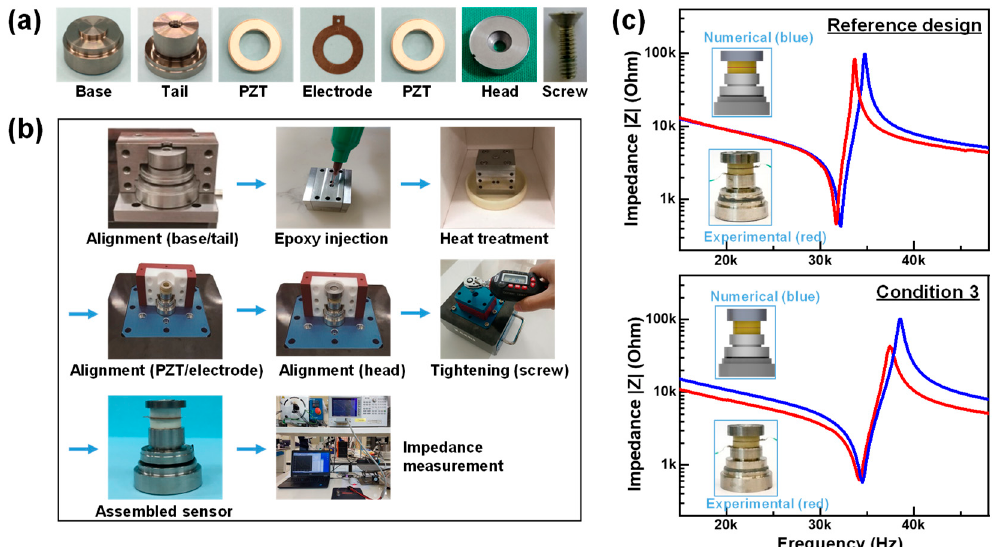
Figure 6. ( a ) Images of internal components fabricated according to the optimized design (condition 3 in Table 5); ( b ) Fabrication procedure of a PZT acceleration sensor module used for measurement of impedance characteristics; ( c ) Impedance spectra obtained from sensor modules (reference design and condition 3). The blue and red lines indicate the numerically simulated and experimentally measured impedance curves, respectively.